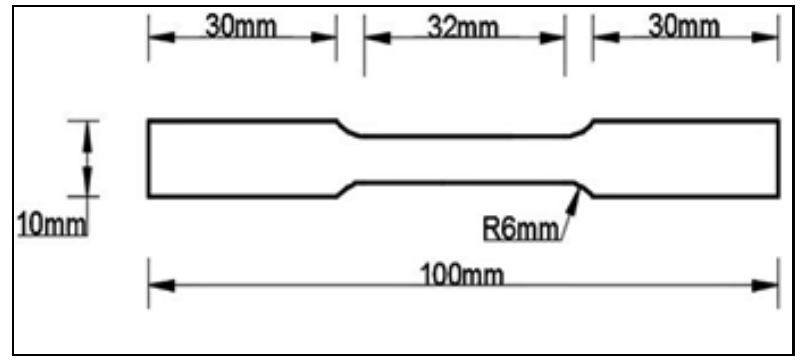
Figure 1. Specification of tensile test specimen.